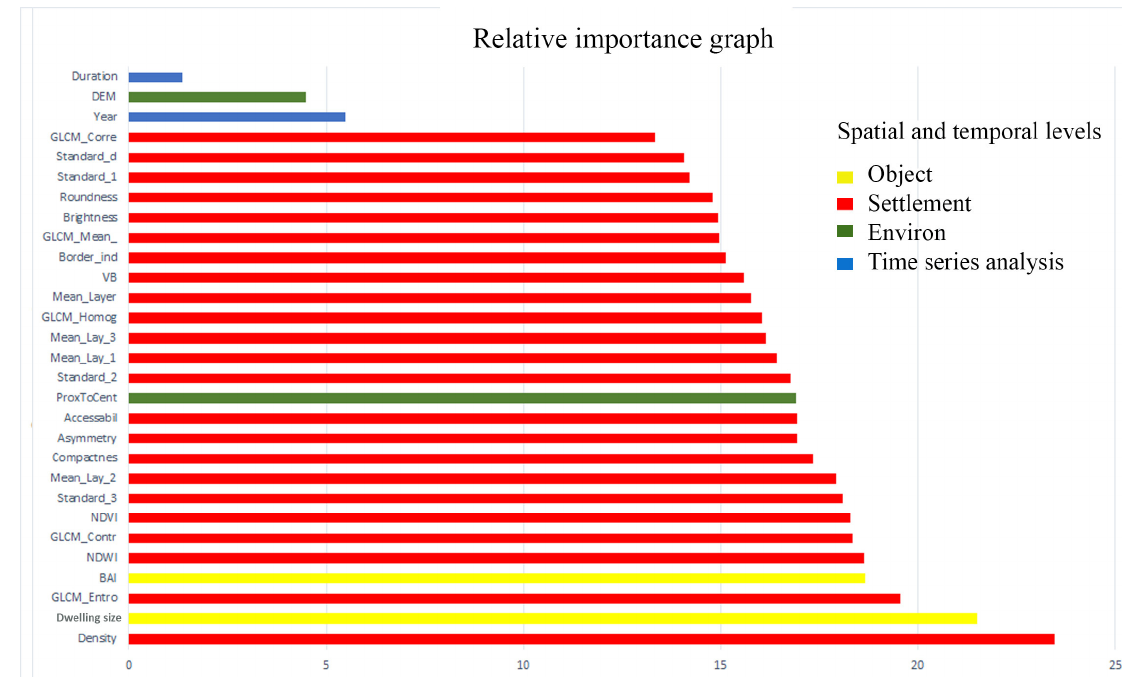
Figure 8. The relative importance of 30 object-based random forests with TSA classification variables in four different spatial and temporal levels. Red bars represent the settlement level, yellow the object level, green the environ level, and blue the time-series analysis.